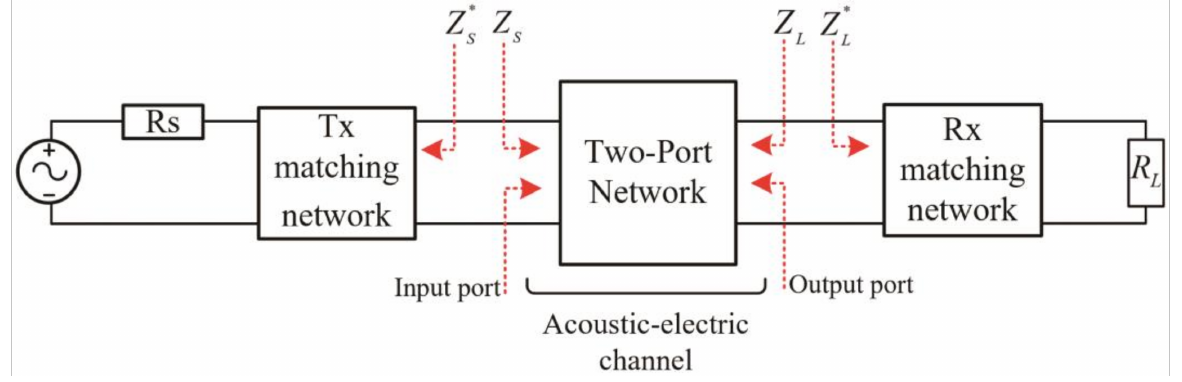
Figure 2. Simplified model of simultaneous conjugate impedance